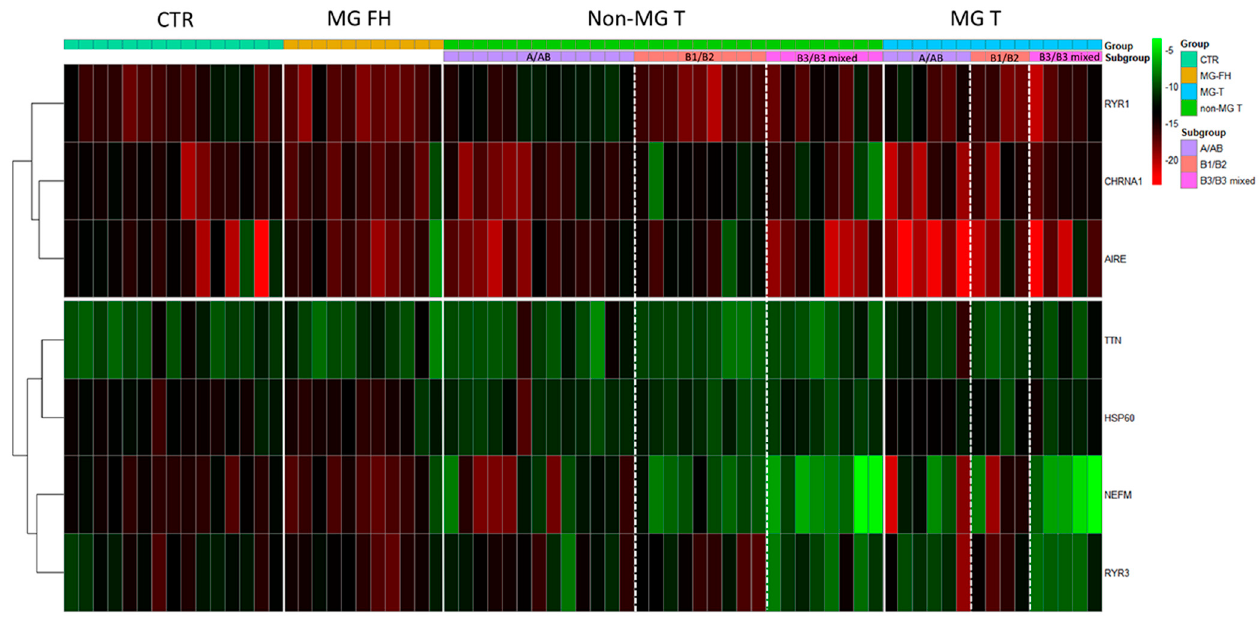
Figure 6. Heatmap of log2 transformed normalized gene expression data (log2(2 − ∆ CT × 100)). The columns (samples) are unclustered, whereas the rows (genes) are clustered according to differential gene expression in MG compared to normal control thymuses (CTR) and thymomas from non-MG patients (NON-MG T). MG thymuses included follicular hyperplastic (MG FH) and thymoma (MG T) thymuses from corticosteroid-naïve MG patients. The color and intensity of the boxes are used to represent relative values of gene expression, with red representing lower levels and green representing higher levels.